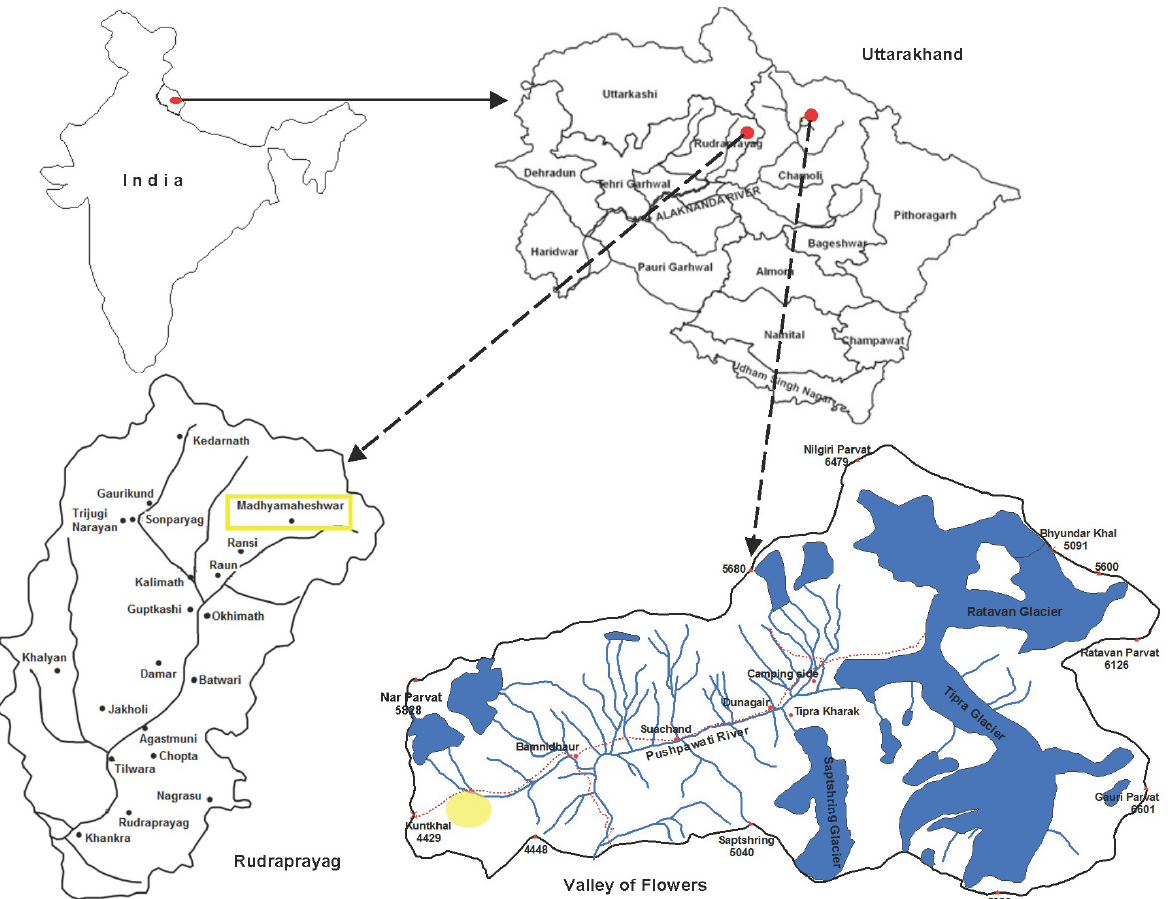
Image 4. Map showing current distribution record of Gentiana